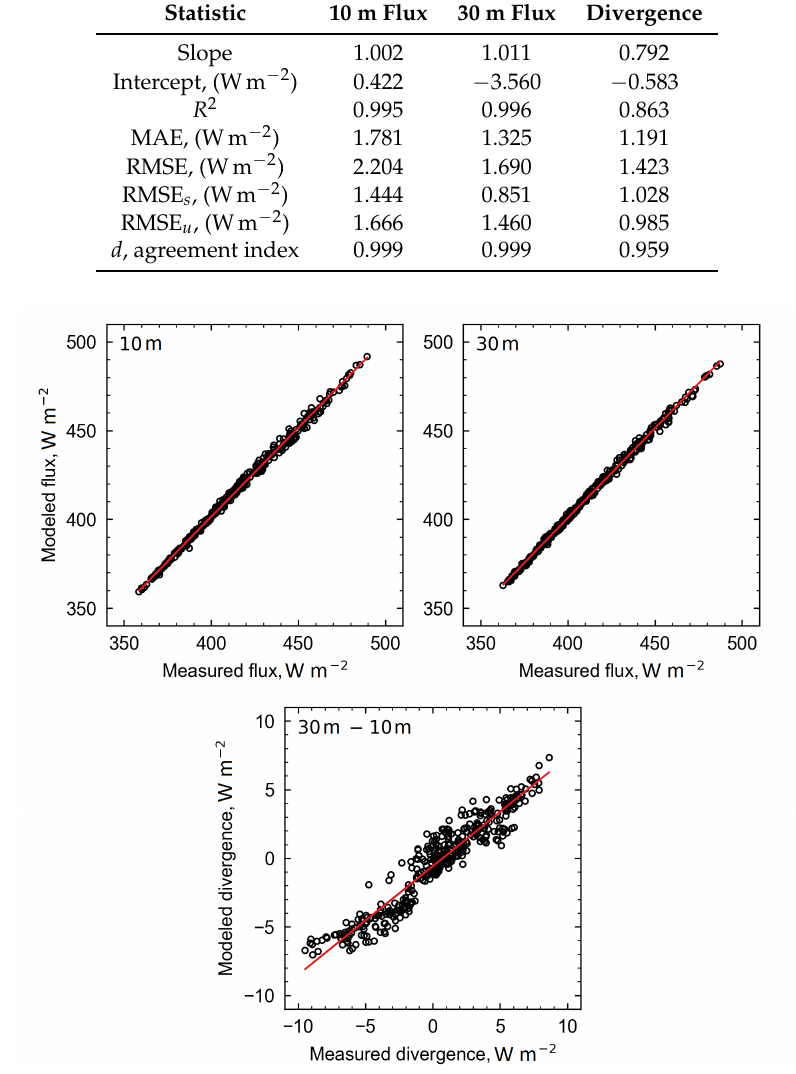
Figure 7. A comparison of 10 m and 30 m measured and modeled longwave fluxes and divergences—calculated as the difference between 30 m and 10 m fluxes—over the 14-day evaluation period at Payerne,